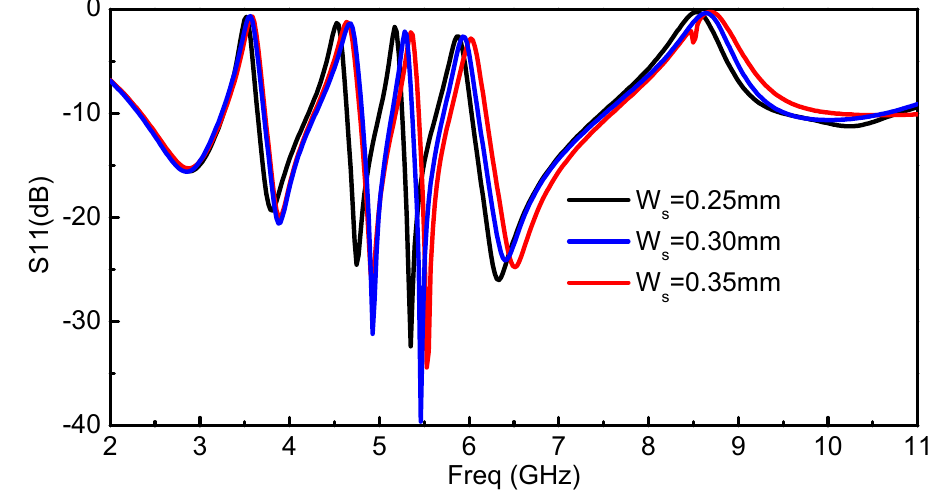
Figure 7. Effect of critical parameter W s on the response of the proposed antenna.